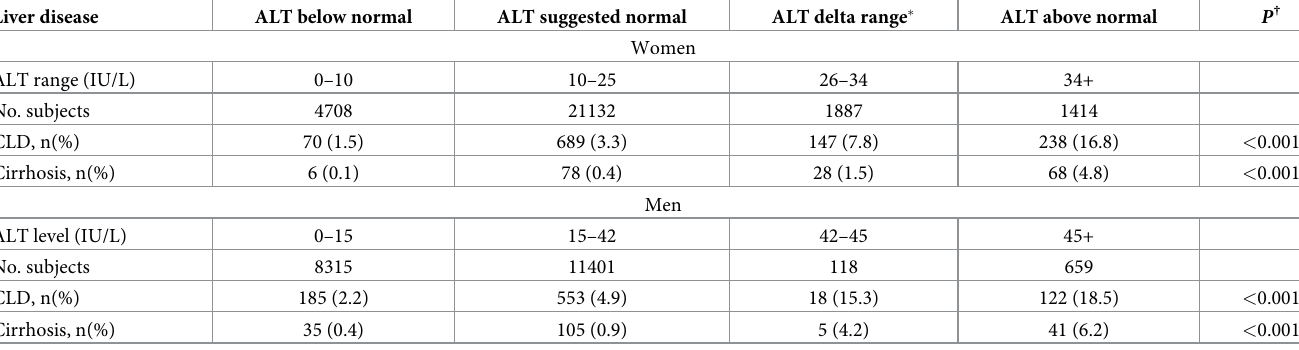
Fig 2 shows the results of the ROC curve analysis of the power of the fibrosis scores to pre- dict cirrhosis. The AUC was 0.821 for the APRI and 0.78 for the FIB-4. However, owing to their low sensitivity and specificity, these tests cannot serve as screening tools for cirrhosis. Subjects with CLD or cirrhosis had significantly higher ALT and AST levels and a signifi- cantly lower platelet count than subjects without liver disease. The APRI and FIB-4 fibrosis scores were significantly higher in the subjects with CLD, and specifically the cirrhotic Table 2. Prevalence of cirrhosis and CLD by ALT categories in women and men. Liver